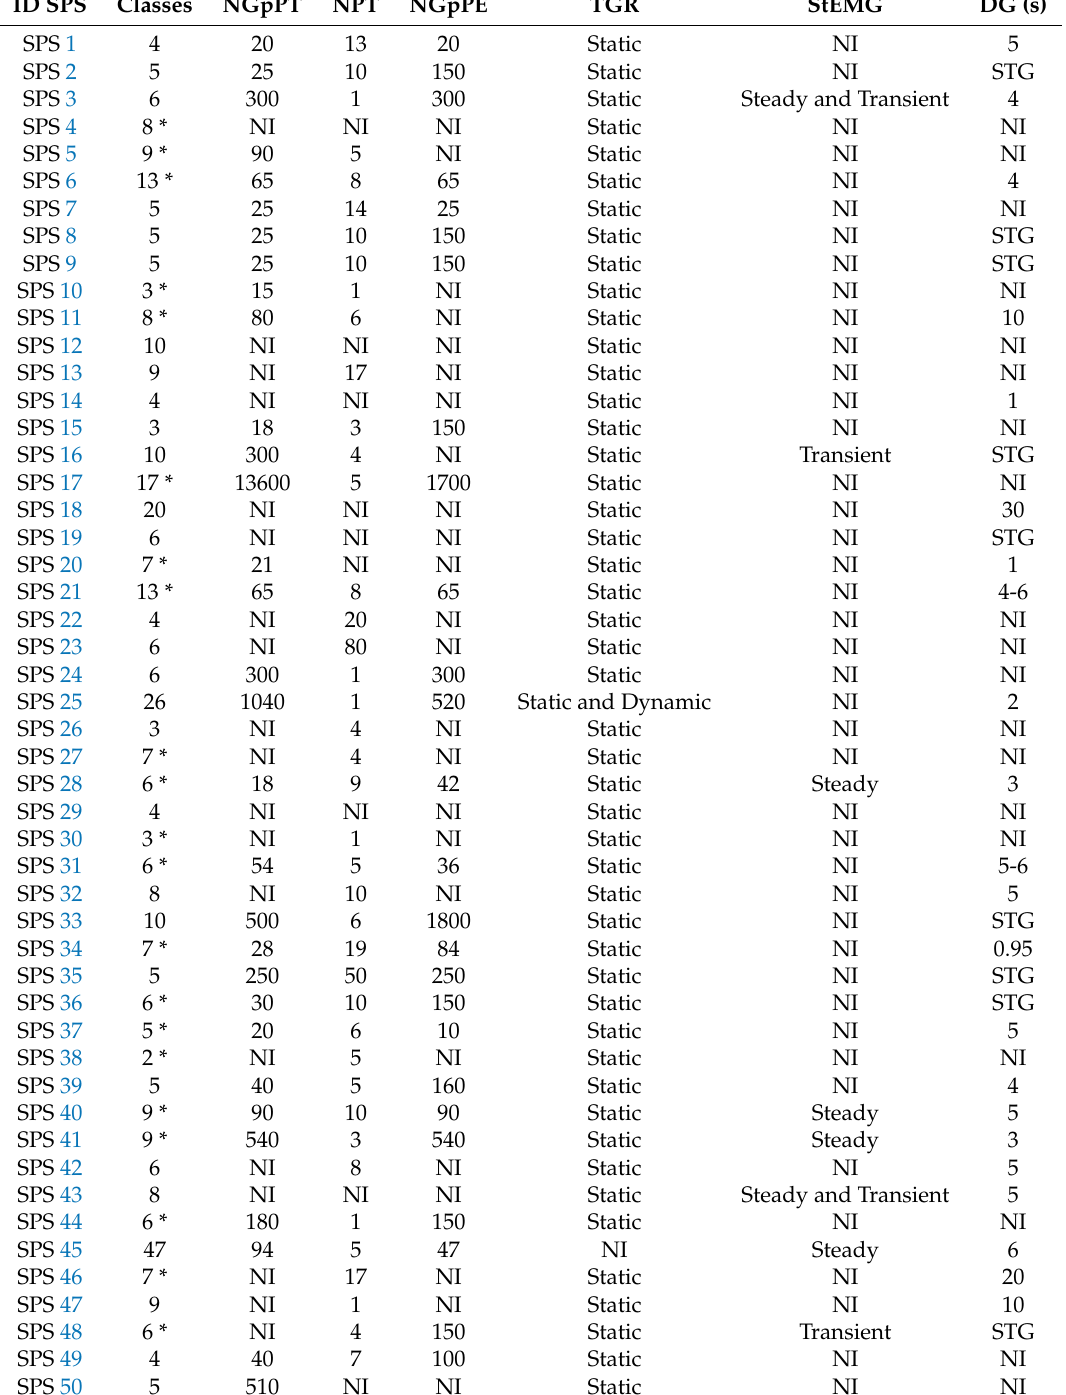
Table 11. The number of gestures recognized (i.e., classes), number of gestures per person in the training set (NGpPT), the number of people who participated in the training (NPT), the number of gestures per person in the evaluation set (NGpPE), the type of gestures recognized, the state of the EMG data used, and the duration of the gestures